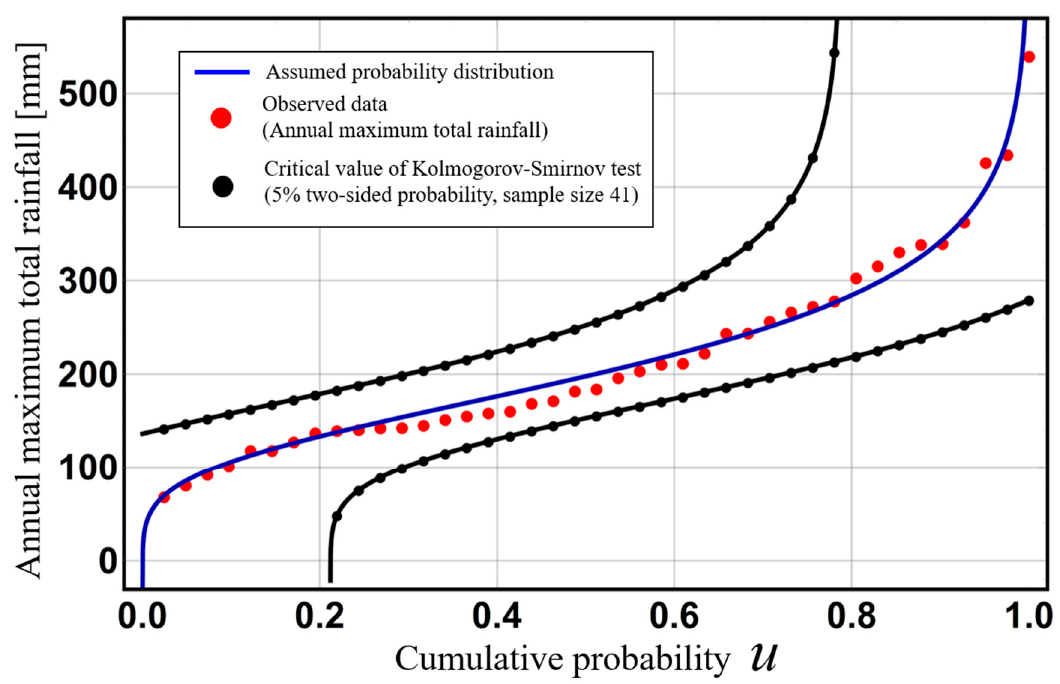
Figure 3. Observed data for annual maximum total rainfall from 1977 to 2018 in the Kusaki dam basin, with a Gumbel distribution that these observed data are assumed to follow and a critical line for the case of 5% two-sided probability in the Kolmogorov–Smirnov test.